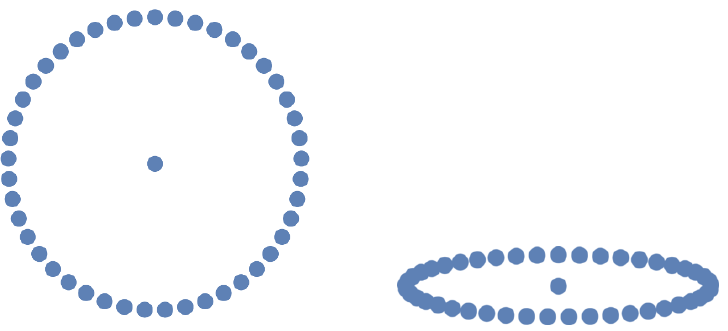
Figure 7 . Left: a circular void with a vacuum in the middle. The long-lived 0-cycle will die at the same time as the long-lived 1-cycle. Right: an oblique void with a vacuum in the middle. The 0-cycle will die before the 1-cycle dies, and an extra short-lived 1-cycle will